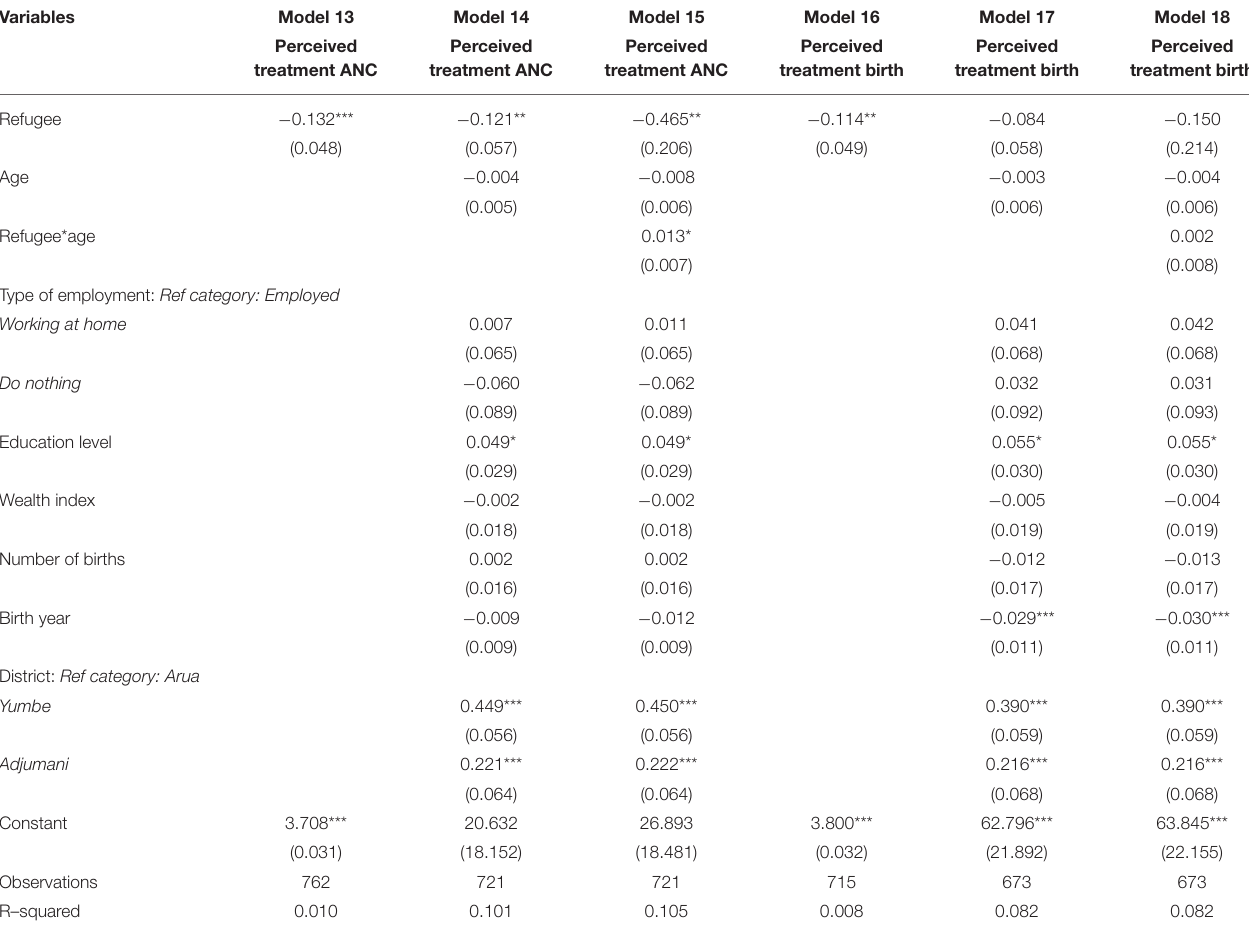
TABLE 4 | OLS regression testing perceived quality of treatment and refugee